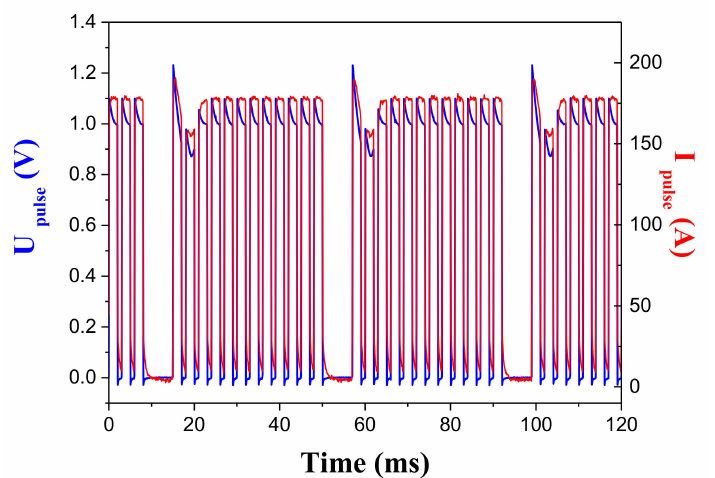
Figure 14. SPS pulse pattern, with an On:Off setting of 12:2, delivered using the homemade pulse generator to the tabletop